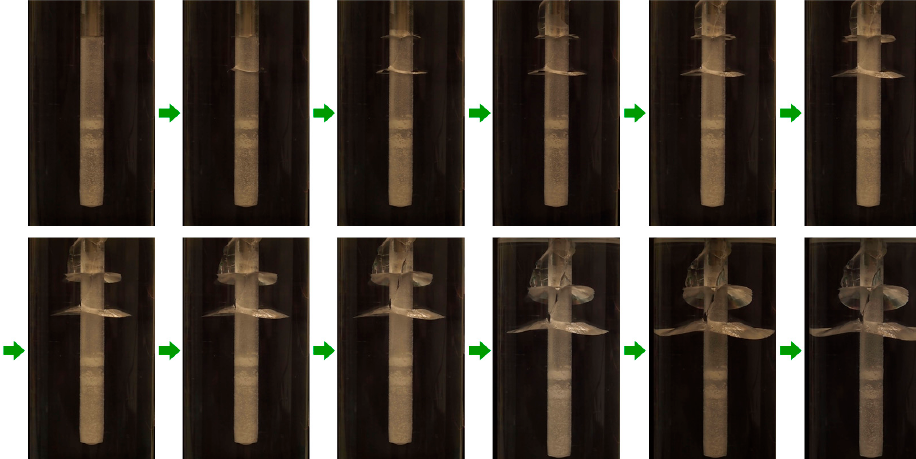
Figure 6. Crack development in Specimen 2.